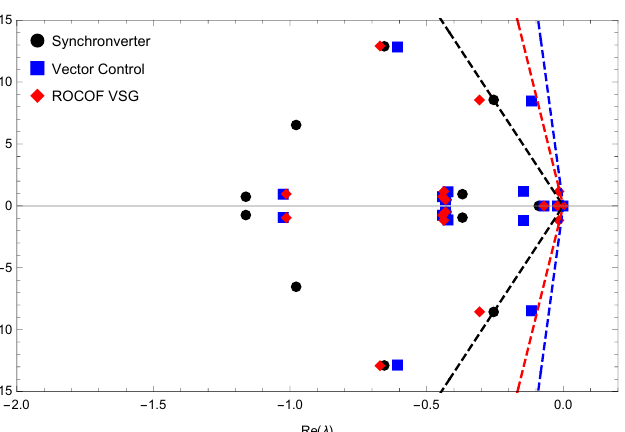
Figure 8. Eigenvalues of the IEEE 9 bus system with VSC connected to Node 6. Black dashed line shows ξ min = 0.0298 of the system with synchronverters. Red dashed line corresponds to ξ min = 0.0112 for ROCOF VSG control. Blue dashed line corresponds to ξ min = 0.0062 for vector